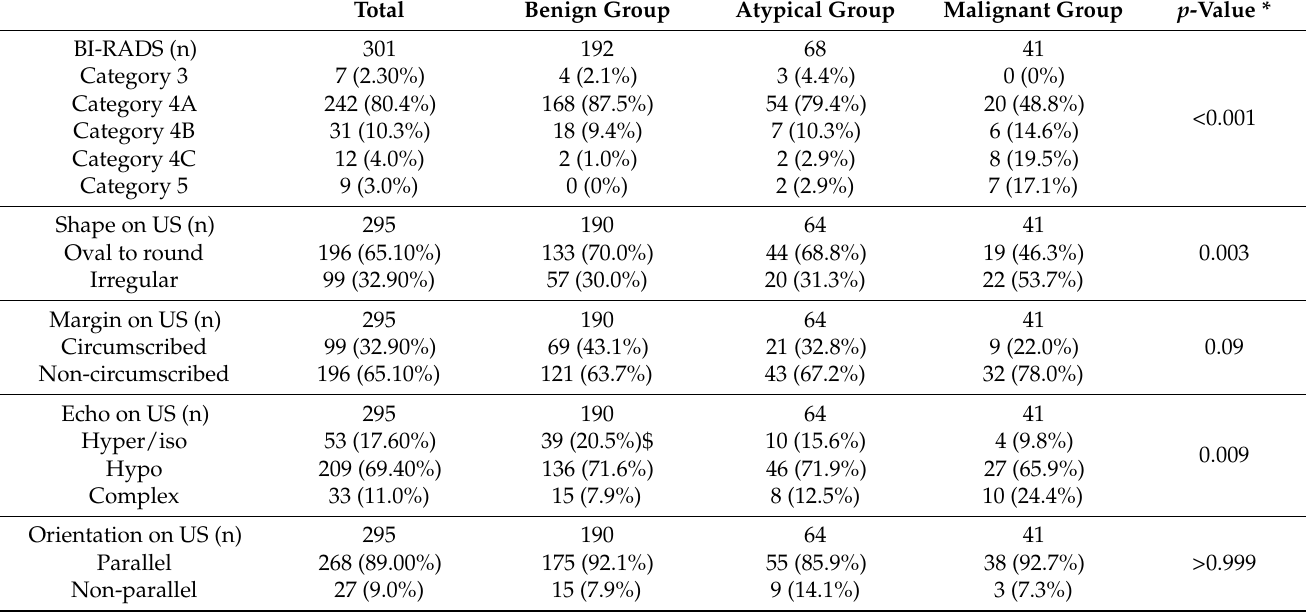
Figure 1. A 46-year-old woman presented with palpable masses in the breast accompanied by bloody nipple discharge. ( a ) Mammography shows a hyperdense mass with spiculated margins and an irregular shape in the upper central portion (arrowheads) and a circumscribed round hyperdense mass in the upper inner portion of right breast (arrows). ( b ) Ultrasound shows a 3.9 cm heterogeneous echoic mass (arrowheads) with irregular shape and internal vascularity in the right breast, in the 1 o’clock position, 5 cm from the nipple. Another 2.7 cm complex cystic and solid mass (arrows) is noted in the right breast in the 2 o’clock position, 6 cm from the nipple. Ductal carcinoma in situ with focal invasion in the background of papilloma was confirmed by surgery. The patient had a family history of breast cancer (mother). Table 2. Imaging characteristics of papillary lesions according to final pathology. Total Benign Group Atypical